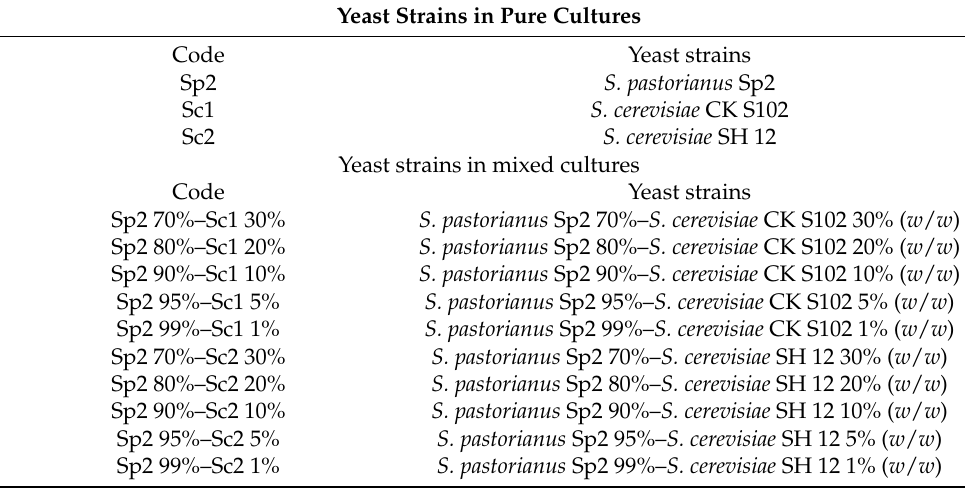
Table 1. Saccharomyces yeast species in pure and mixed cultures in different inoculation ratios. Yeast Strains in Pure